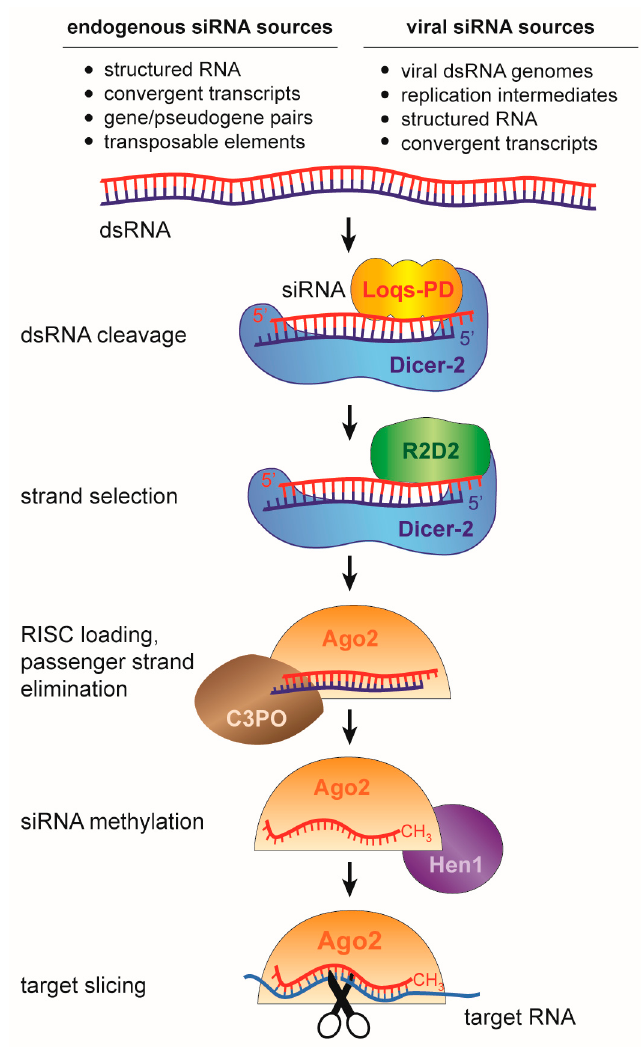
Figure 1. The small interfering RNA (siRNA) pathway in Drosophila melanogaster . Double-stranded RNA precursors of different sources are processed by Dicer-2 into short interfering RNAs of ~21 nt in size. The siRNA duplex is loaded into an Argonaute2 containing RISC complex, where one strand (passenger) is degraded, and the guide strand is retained. The guide strand mediates target RNA recognition through Watson-Crick base pairing, followed by target cleavage (slicing) by Argonaute. Loqs-PD is required for endo-siRNA biogenesis, but dispensable for viral siRNA (vsiRNA) biogenesis.